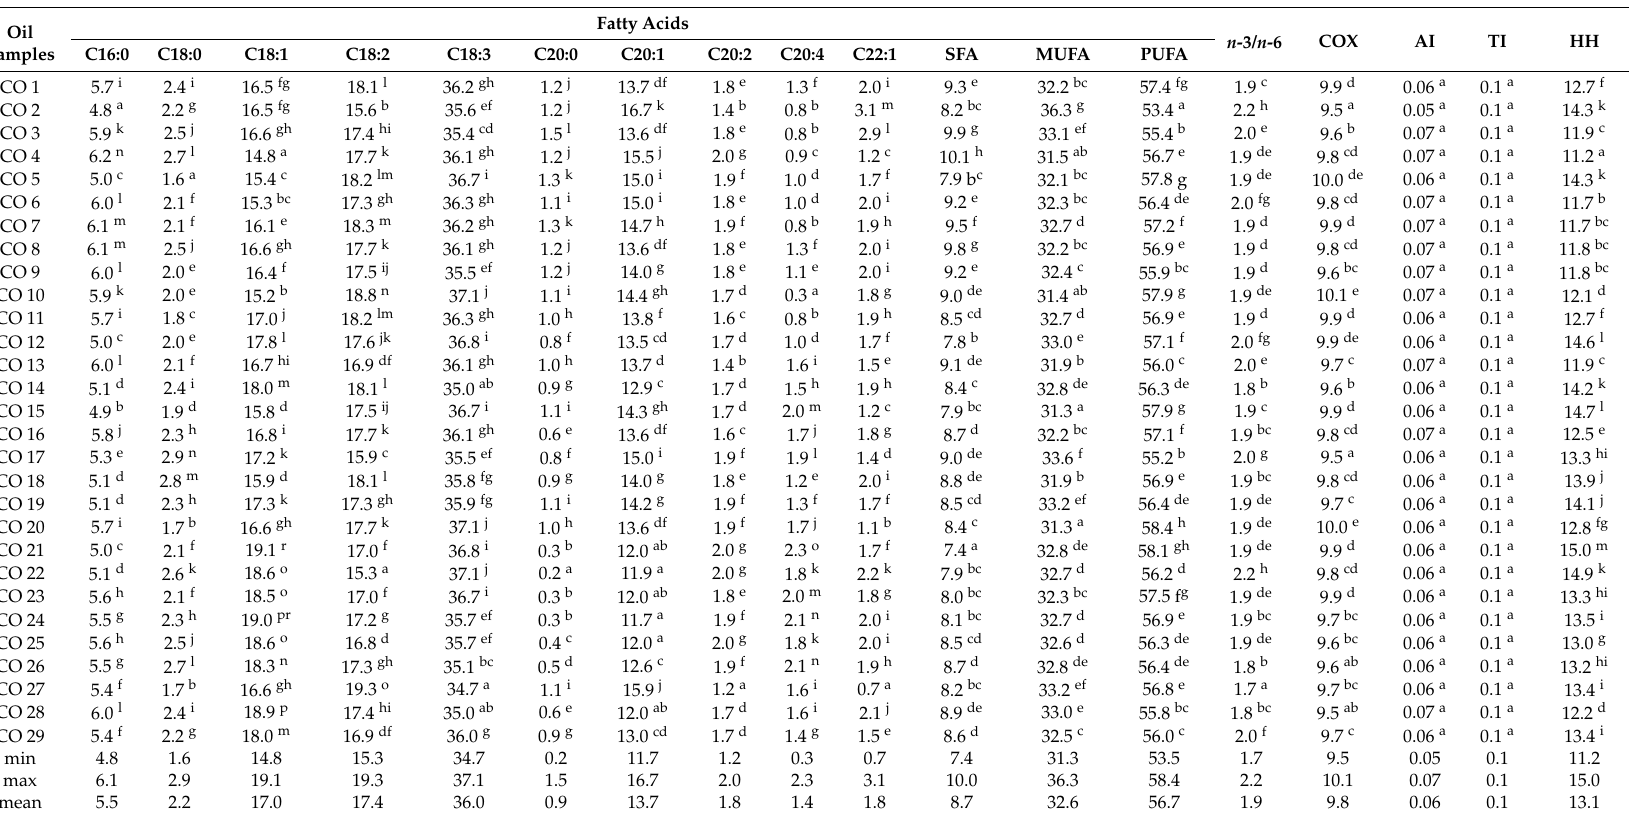
Table 2. Fatty acid composition and nutritional value of analyzed camelina